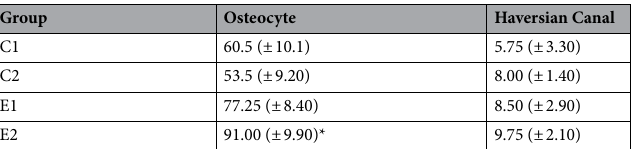
Table 7. Osteocyte and Haversian canal count in the ROI. The data is depicted as mean ± standard deviation (SD). *The osteocytes found in the E2 group were significantly higher than in the C1 and C2 groups, p = 0.002).